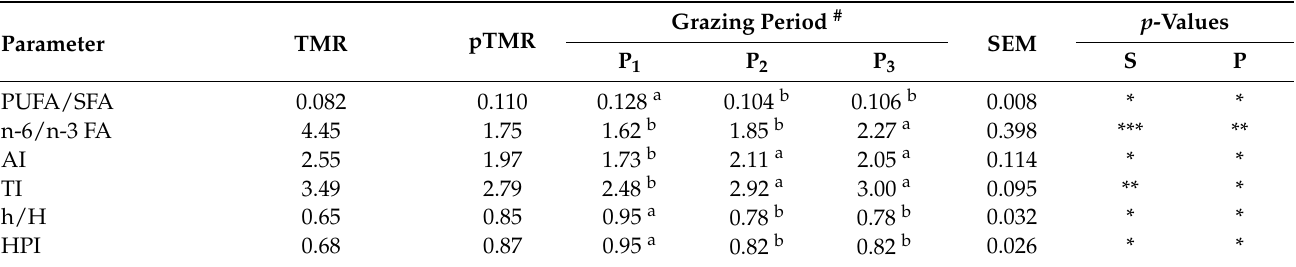
Table 5. Effect of cow feeding system (S: TMR vs. pTMR) and grazing period (P) on health lipid indices in